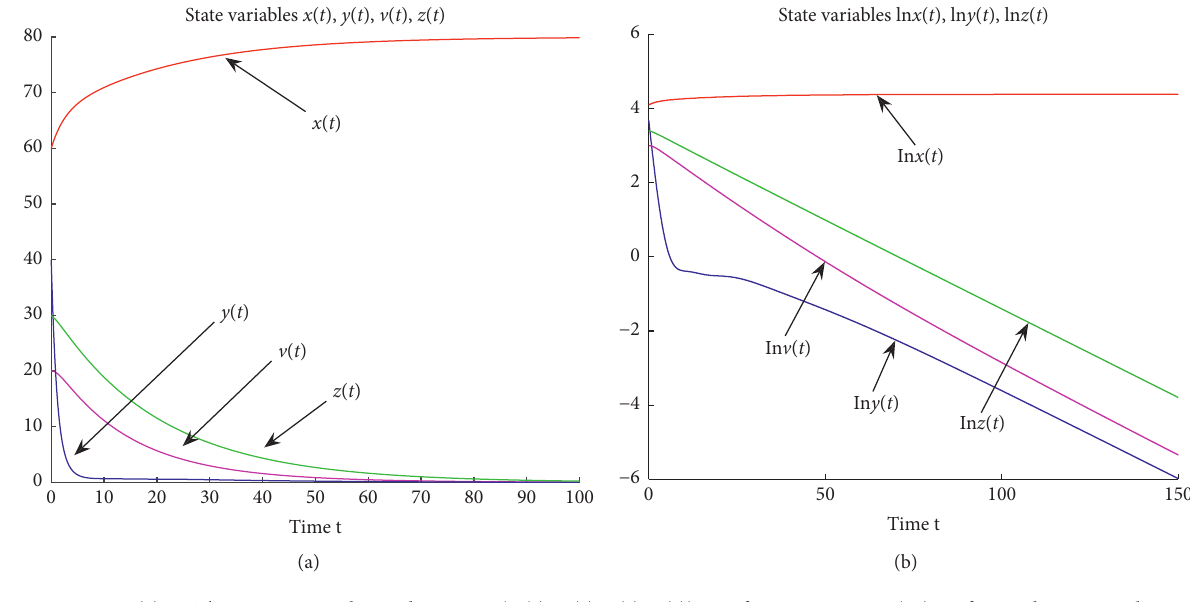
of China (18B456, 19C0985, 19C0976), the construct pro- gram of the applied characteristic discipline “Applied Economics” in Hunan Province.